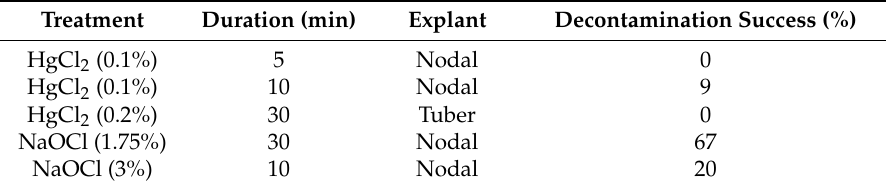
Table 1. Surface decontamination of Brachystelma pygmaeum plant material using mercuric chloride (HgCl 2 ) and sodium hypochlorite (NaOCl) for di ff erent time durations. Treatment Duration (min) Explant Decontamination Success (%) HgCl 2 (0.1%) 5 Nodal 0 HgCl 2 (0.1%) 10 Nodal